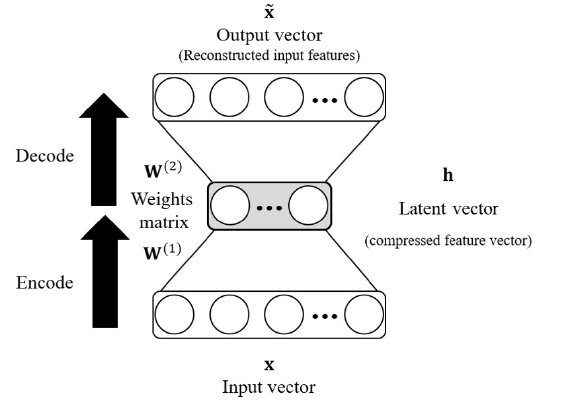
Figure 1. Structure of the autoencoder